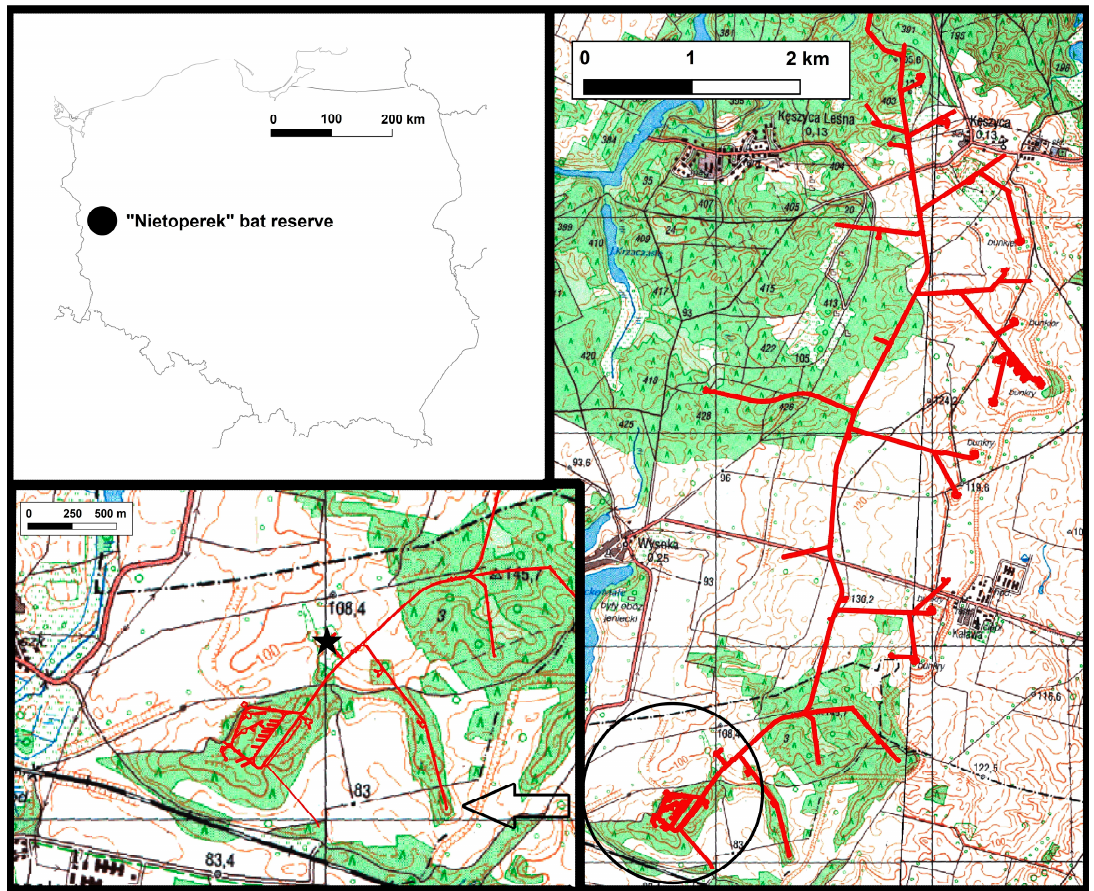
Figure 1. Underground corridors of Central Sector of Mi ę dzyrzecz Fortified Front in Western Poland. Netting place in the entrance to bunker Pz.W. 766 is marked by a black asterisk.